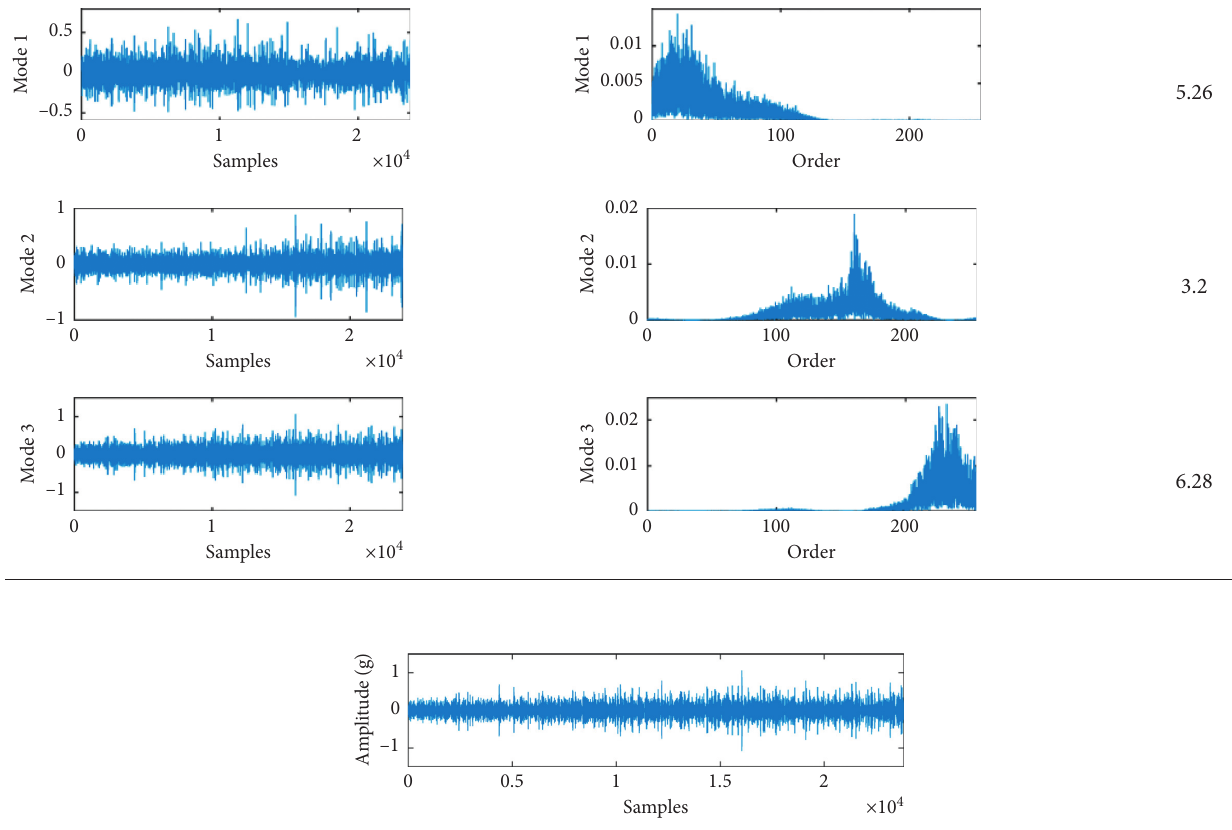
Table 6: Fitness values obtained by analyzing the outer race fault signal with VMD. Modes obtained by VMD and their order spectra